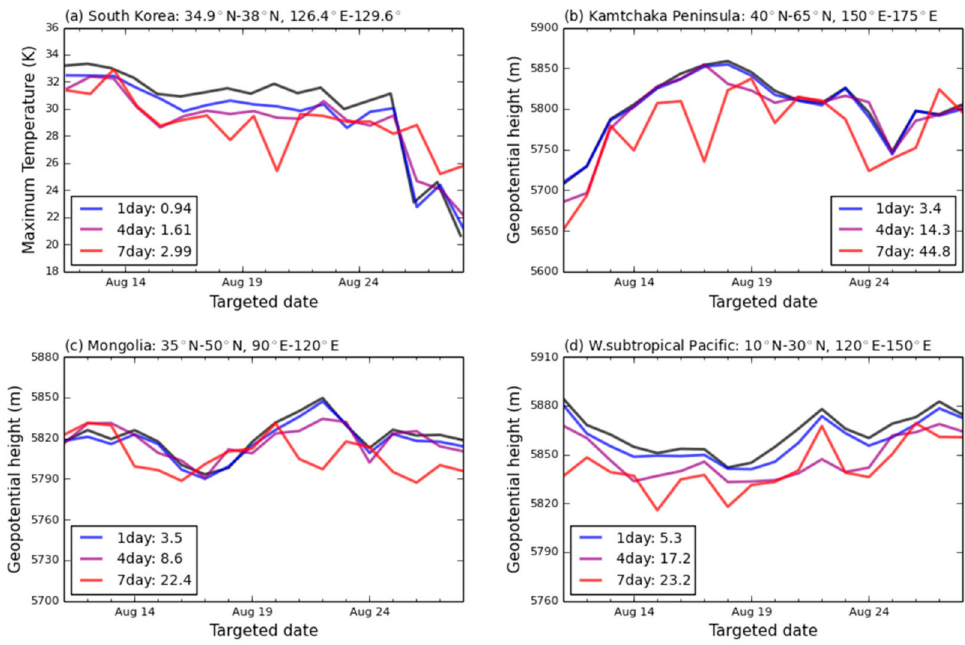
Figure 4. ( a ) Time series of daily maximum temperature ( ◦ C) averaged over South Korea in the CTL experiment at each forecast day (day 1, day 4 and day 7) with the MetUM analysis (black). ( b – d ) are time series of 500 gph height averaged over ( b ) the Kamchatka Peninsula (40 ◦ N–65 ◦ N, 150 ◦ E–175 ◦ E) ( c ) Mongolia (35 ◦ N–50 ◦ N, 90 ◦ E–125 ◦ E) and ( d ) the northwest Pacific (10 ◦ N–30 ◦ N, 120 ◦ E–150 ◦ E) in the CTL experiment at each forecast day (day 1, day 4 and day 7) with the MetUM analysis (black). Numbers in the box are the root mean square error (RMSE) at each forecast lead